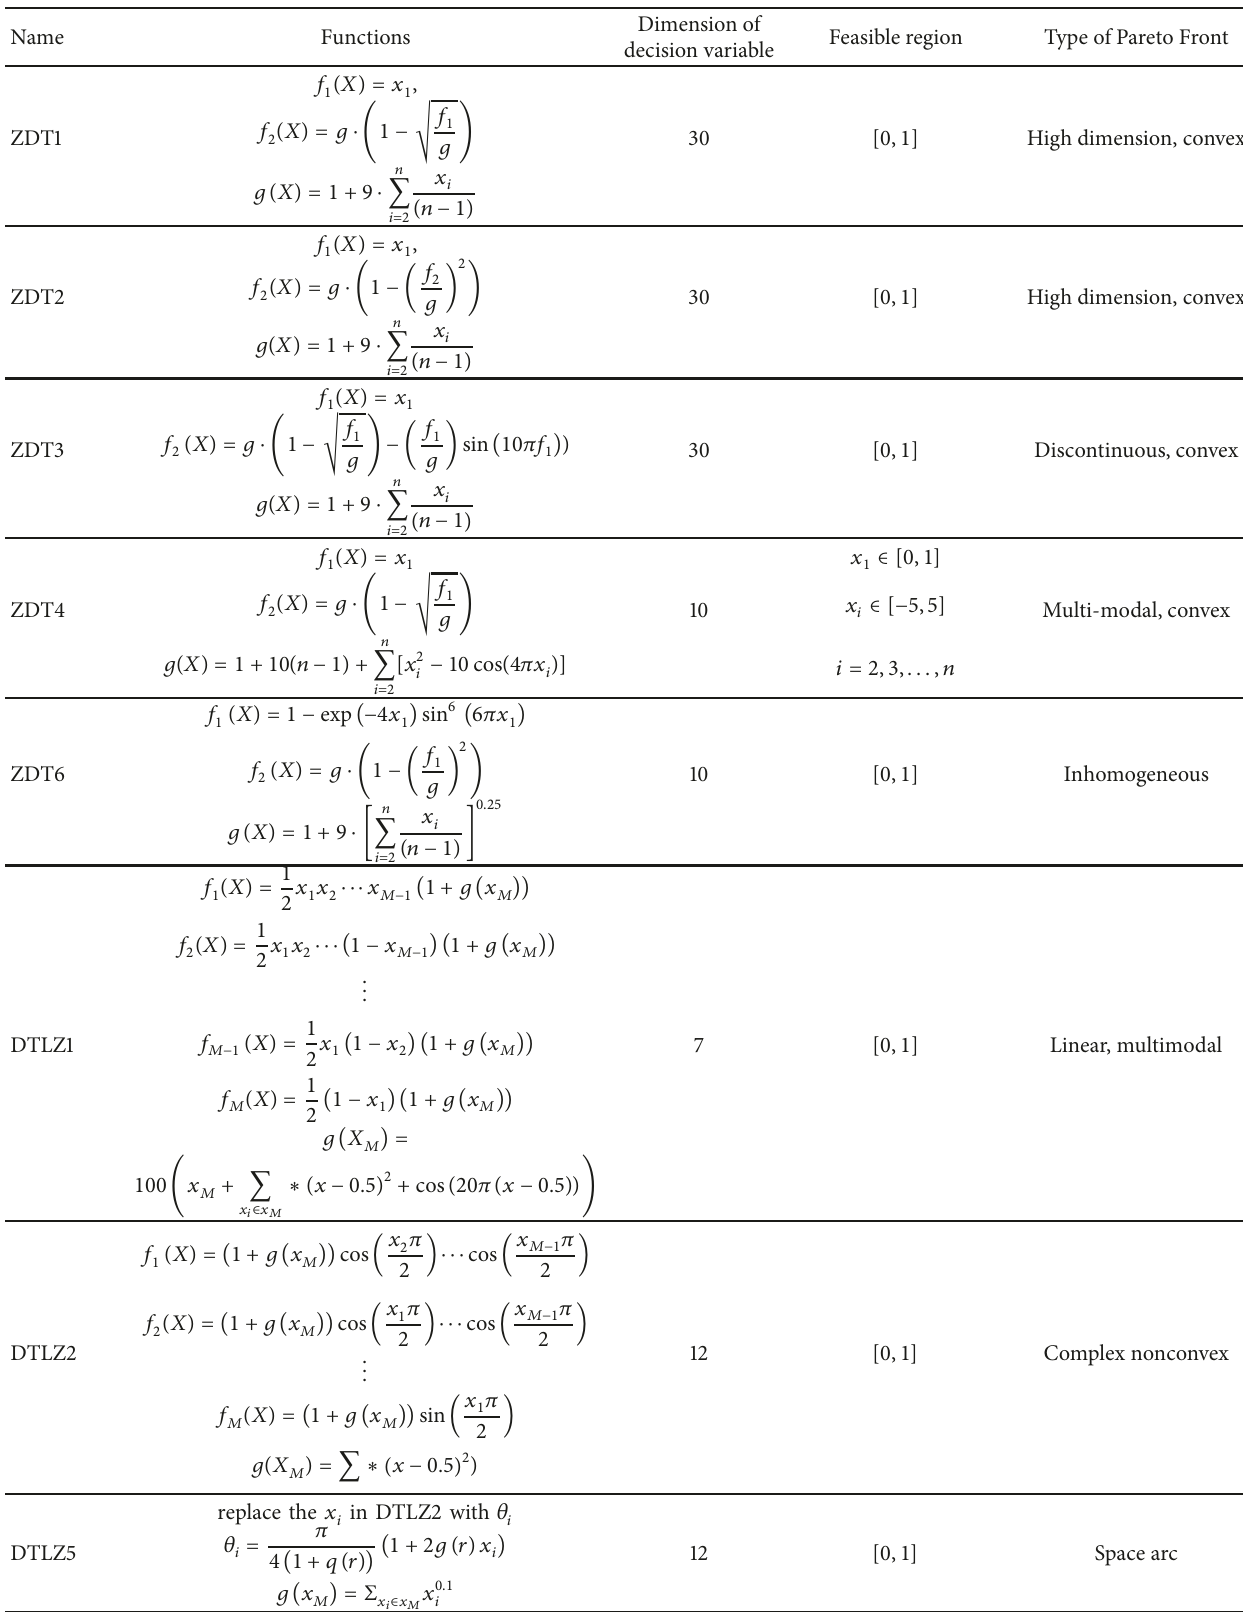
Table 1: Eight test functions for